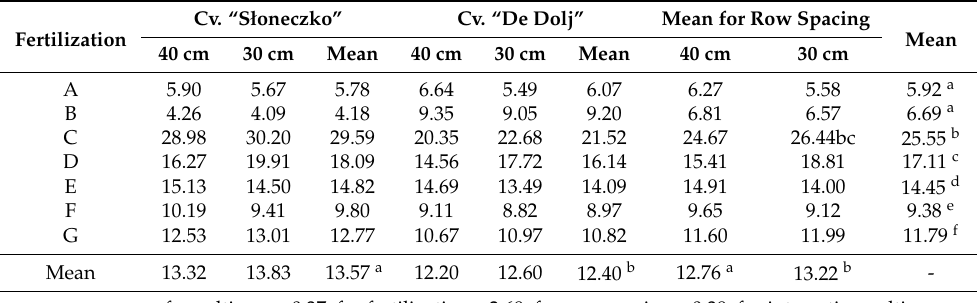
for cultivars—0.37; for fertilization—2.69; for row spacing—0.39; for interaction cultivar × row spacing—n.s.; for interaction cultivar × fertilization—1.78; for interaction row spacing × fertilization—1.76; for interaction cultivar × row spacing × fertilization—n.s. A. control treatment; B. mineral NPK fertilization (100%); C. SMS (100%); D. SMS (70%) + NPK (30%); E. SMS (50%) + NPK (50%); F. SMS (30%) + NPK (70%); G. manure; means for the main effects of the